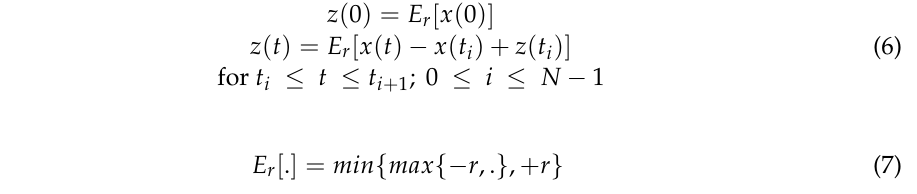
Figure 5c. It has two thresholds +r and –r and its output for a given input x ( t ) can be defined on the interval [ t i , t i + 1 ] , as